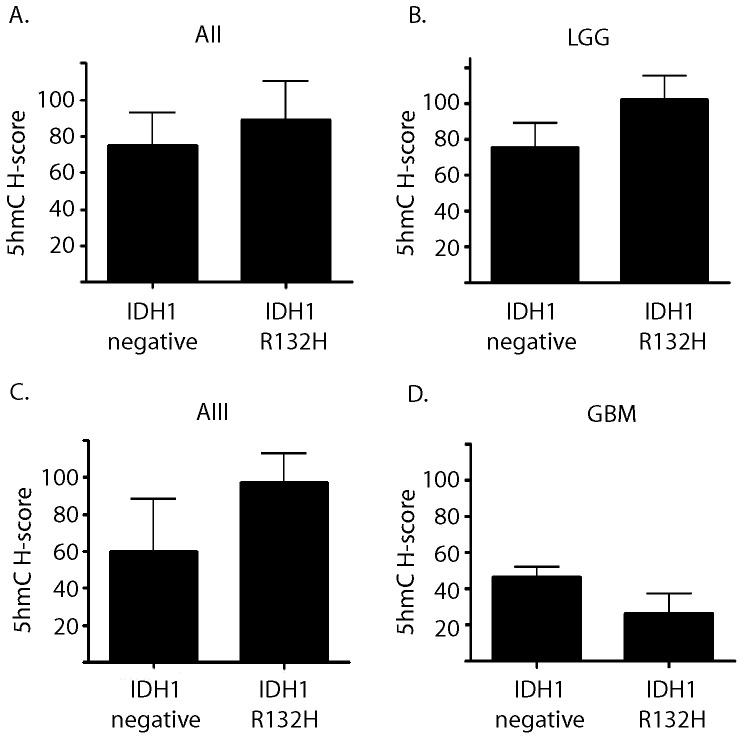
IDH1 R132 H mutation status is not associated with a detectable difference in 5hmC content.Tumors were evaluated for immunoreactivity with antibodies specific for the IDH1 mutant R132H and the corresponding 5hmC levels were correlated with IDH1 immunopositive and immunonegative (IDH1 negative) tumors in (A) grade II astrocytoma, (B) combined low grade gliomas (C) anaplastic astrocytomas, and (D) glioblastoma. No significant difference was identified in 5hmC staining level within any of the specific tumor types.